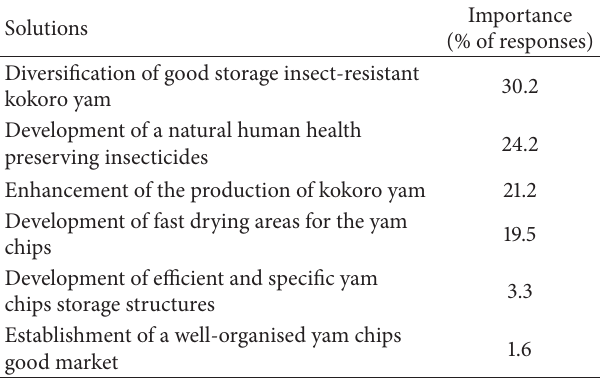
Figure 2: Farmers’ perception of (a) storage loss due to stored yam chips insect pests, (b) the period of infestation of the yam chips.